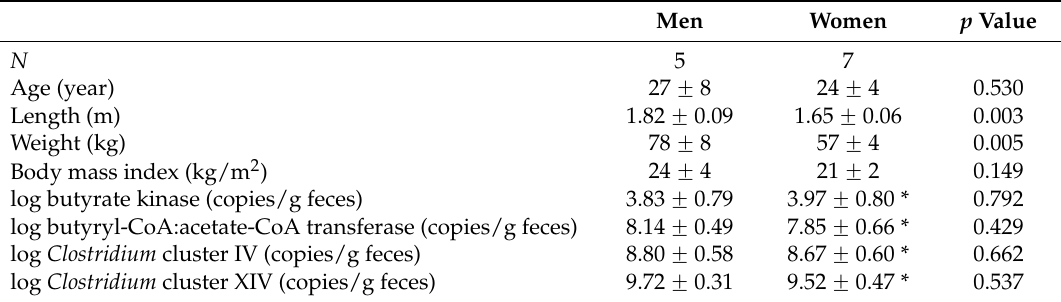
Table 2. Baseline characteristics of the 12 healthy subjects who completed the